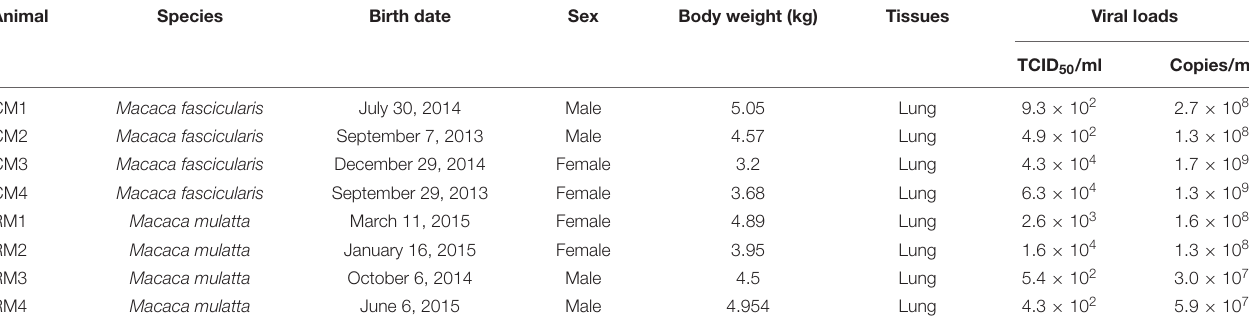
TABLE 1 | Information on the animals and SARS-CoV-2 used in this report. Animal Species Birth date Sex Body weight (kg) Tissues Viral